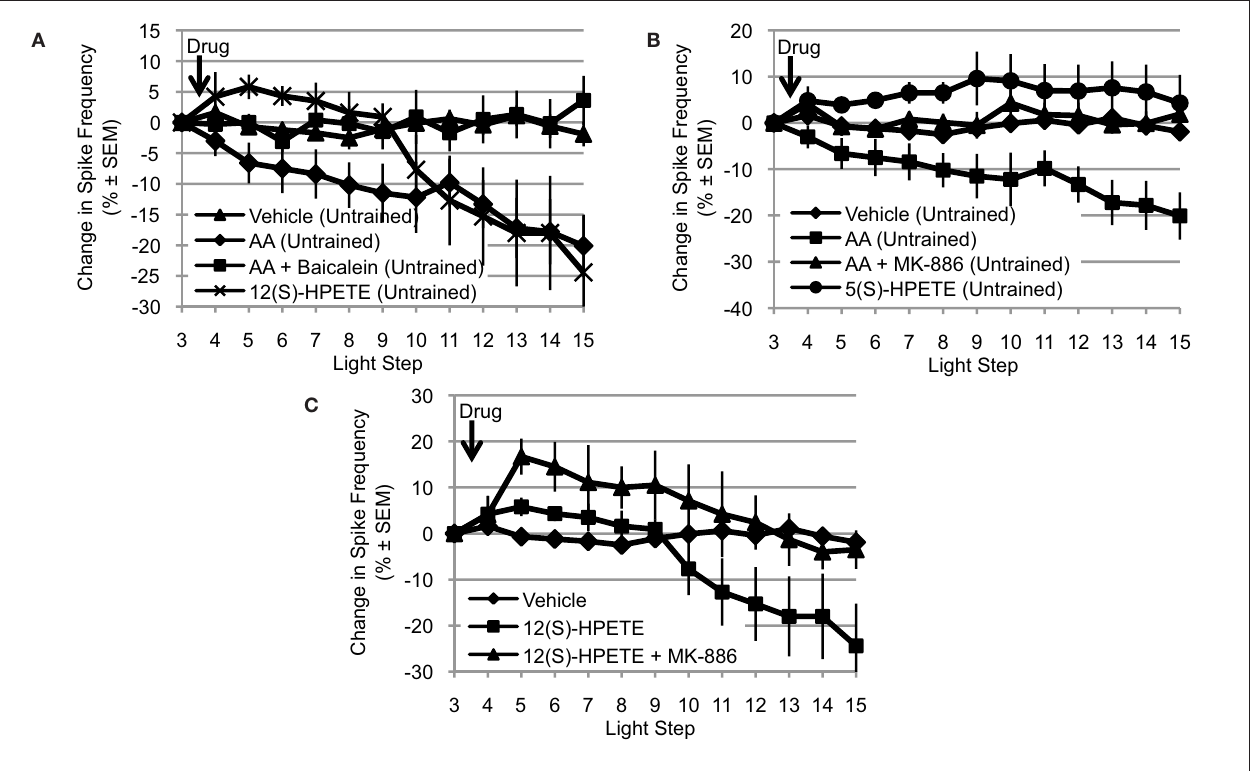
FigurE 3 | The effects of AA are mediated by a 12-lipoxygenase metabolite. (A) Baicalein (10 − 4 M, n = 7), a selective 12-lipoxygenase inhibitor, blocked the reduction in light-evoked spike frequency produced by AA. 12(S)-HPETE (10 − 4 M, n = 5) mimicked the effects of AA on light-evoked spike frequency. (B) MK-886 (10 − 4 M, n = 7), a reportedly selective inhibitor of 5-lipoxygenase activity, also